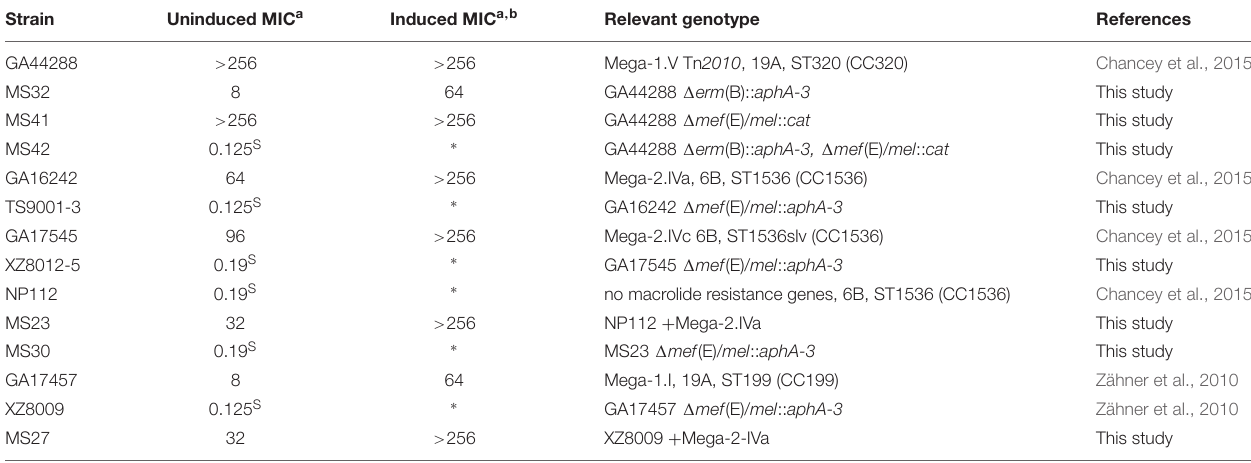
TABLE 2 | Erythromycin minimum inhibitory concentrations (MICs) for S. pneumoniae strains and mutants [Mega insertion, serotype, MLST (clonal complex)] used in this study. Strain Uninduced MIC a Induced MIC a , b Relevant